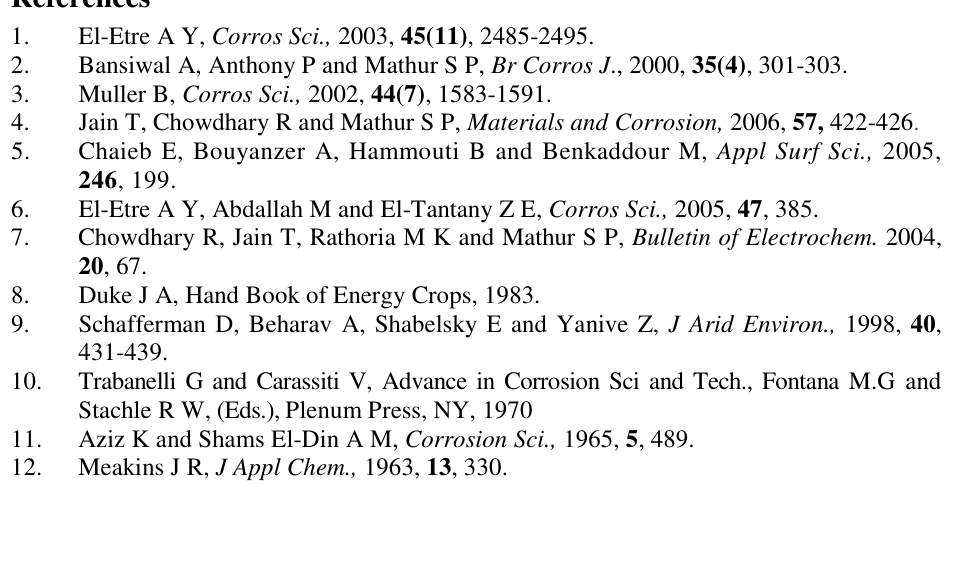
Figure 3 . Langmuir adsorption isotherm of leaves extract for aluminium in 0.5N HCl with inhibitor concentration